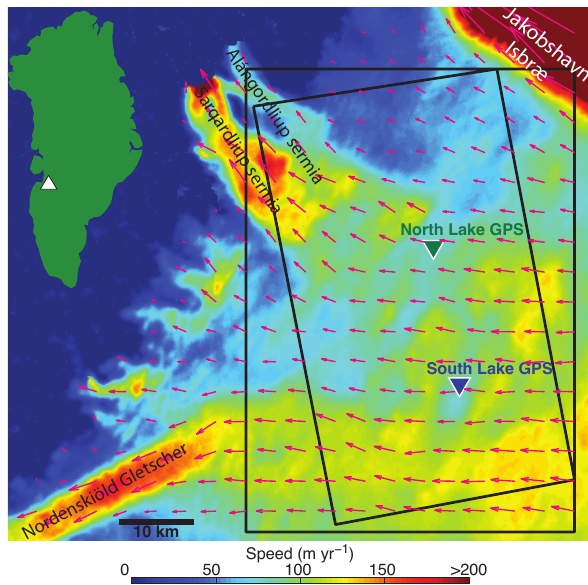
Fig. 1. Map of average flow velocity (arrows and color) from RADARSAT data collected in the winters of 2007–2009 with inset map showing location. Black rectangles show the areas displayed in Figs. 2–4, and triangles show the location of GPS stations used as control